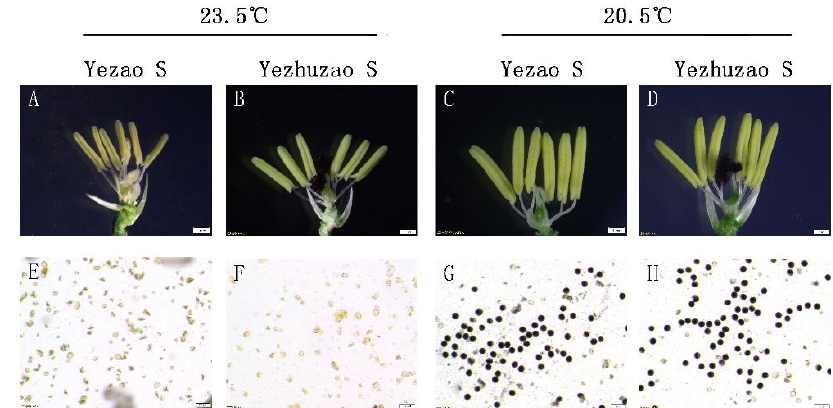
Figure 2. Identification of temperature sensitivity of pollen fertility. ( A – H ) Anther morphology and pollen fertility of Yezao S and Yezhuzao S. Abortive anthers ( A , B ) and pollen ( E , F ) in Yezao S and Yezhuzao S at the restrictive temperature (23.5 °C). Normal anthers ( C , D ) and pollen ( G , H ) in Yezao S and Yezhuzao S at the permissive temperature (20.5 °C). Scale bars, 1 mm ( A – D ) and 100 μm ( E – H ).